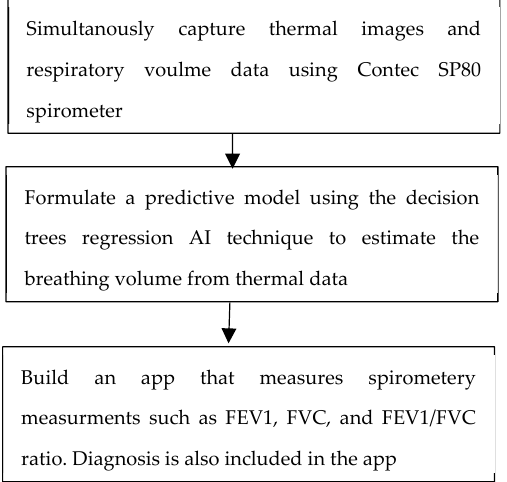
Figure 3. Plan of the spirometry measurement system.